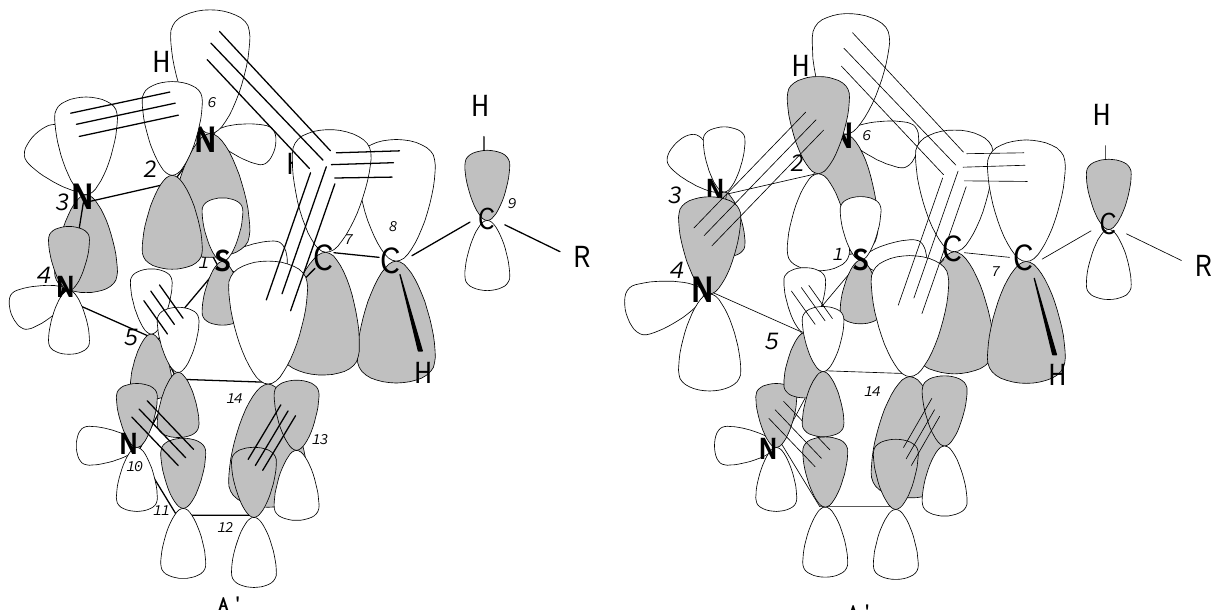
of allyl- (5-pyridin – 2 – yl - [1,3,4] a